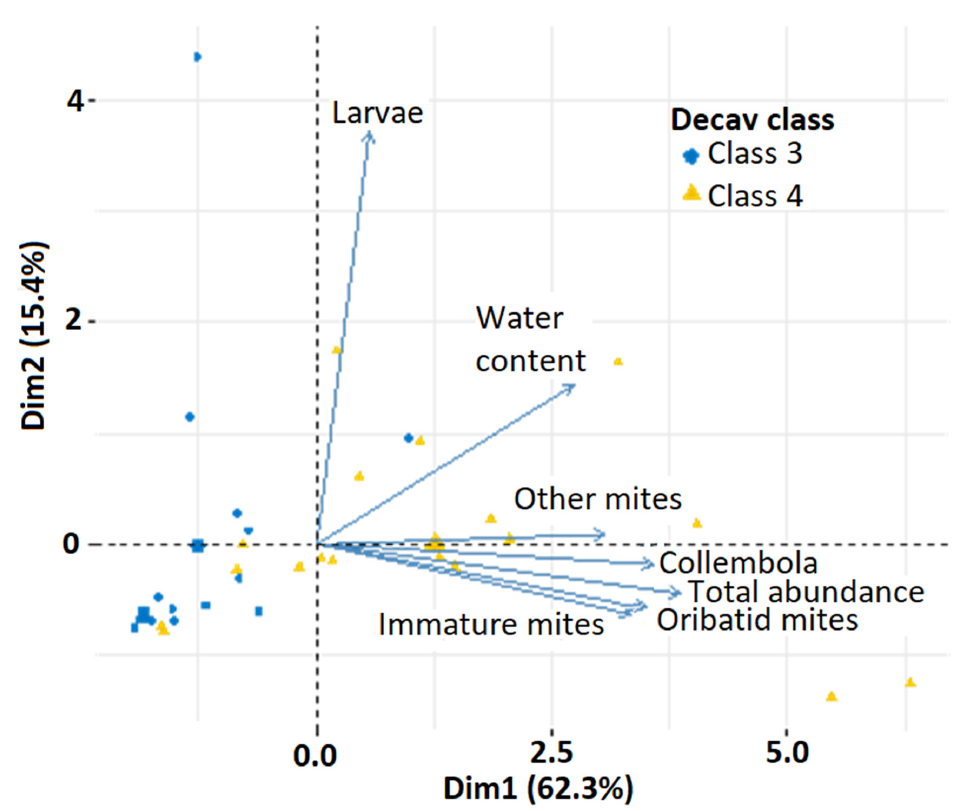
Figure 3. PCA—biplot of CWD decay class for total abundance considering the variables that represented a higher variance: CWD water content, oribatid mites, other mites, Collembola, immature stages of macrofauna (larvae), immature mites, and total abundance of invertebrates. The horizontal axis (Dim1); the vertical axis (Dim2). Decav class: CWD decomposition class.